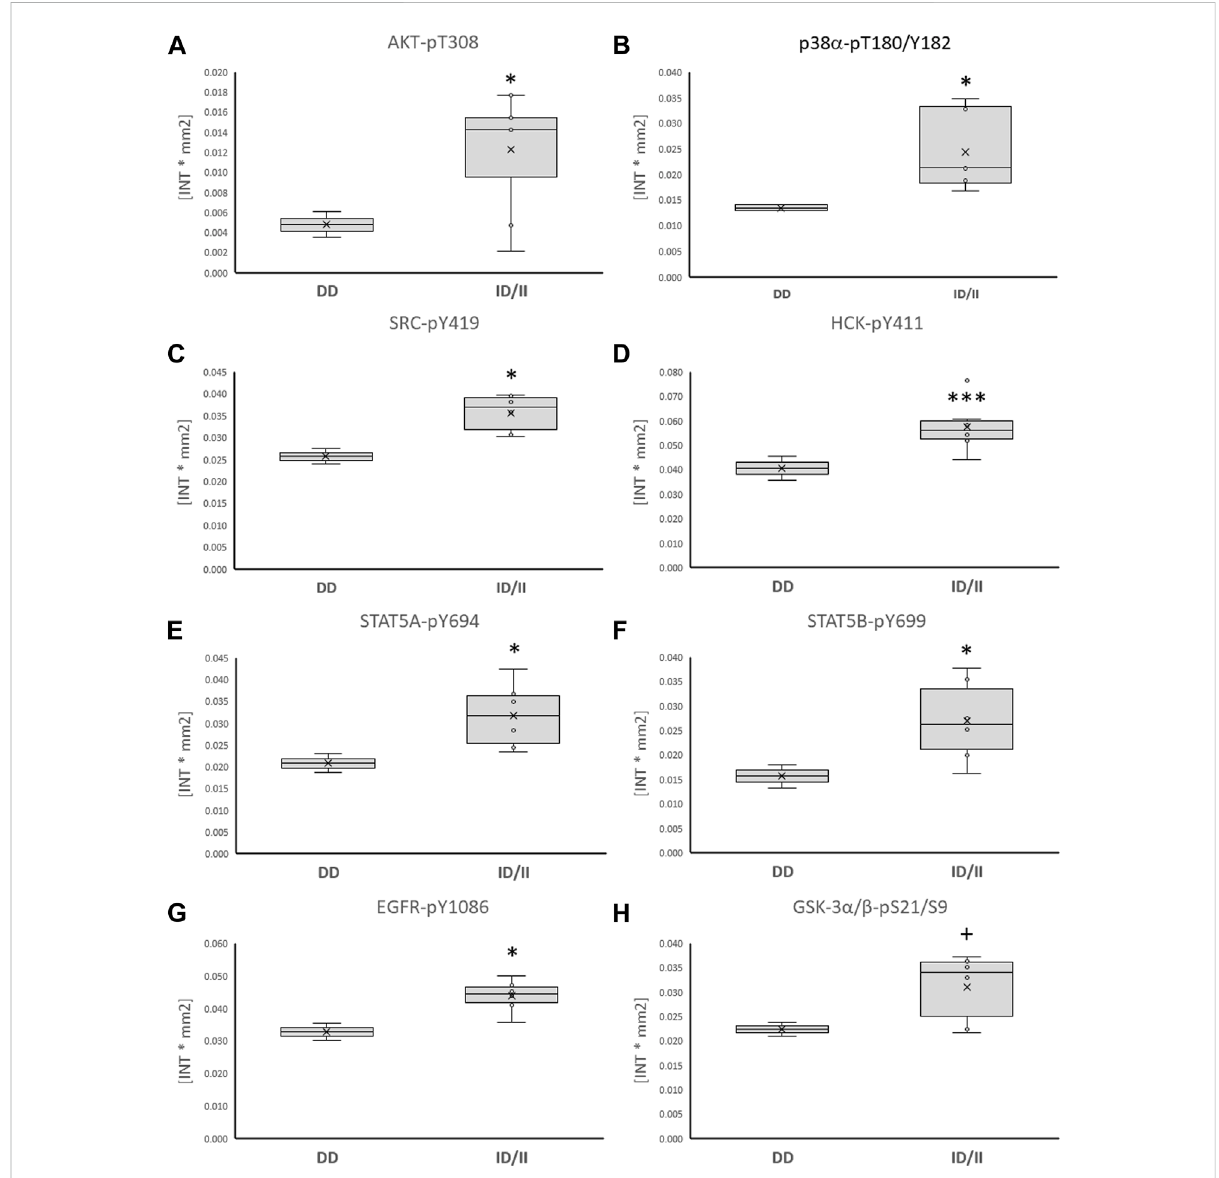
FIGURE 5 Phosphotransferases demonstrating ACE-I/D genotype differences post exercise. Box-Whisker plots of the (referenced) values for the phosphorylation of glucose metabolism related phosphotransferases in the fi t carriers (ACE-ID/II) and non-carriers of the ACE I-allele (ACE-DD) as averageofvalues½and8 hafterone-leggedexercise. (A) AKT-pT308, (B) p38 α -pT180/Y182, (C) SRC-pY419, (D) HCK-pY411, (E) STAT5A-pY694, (F) STAT5B-pY699, (G) EGFR-pY1086, (H) GSK3 α / β -pS21/S9.+,*and***, p < 0.10, < 0.05, < 0.001fordifferencesvs.ACE-DDgenotype.ANOVAfor the factor ACE-I/D